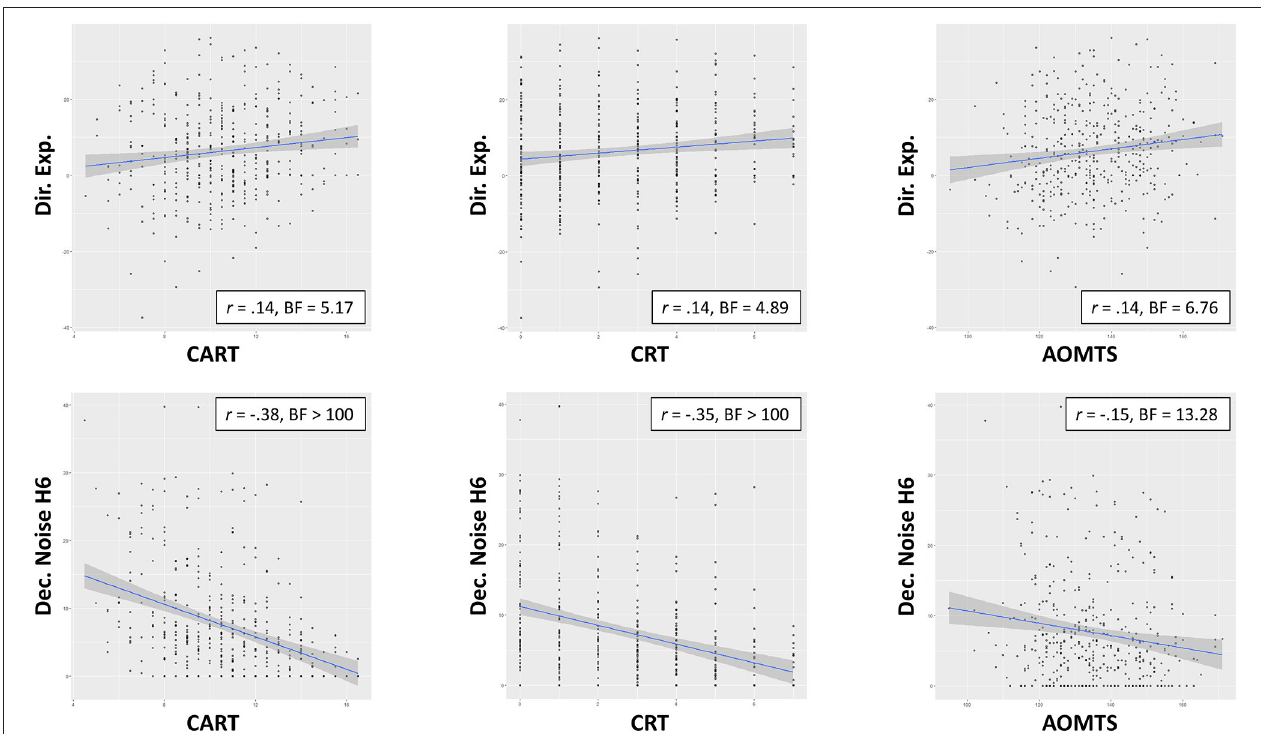
FIGURE 4 | Relationships between self-reported reflectiveness (CART. CRT-7, AOMTS), directed exploration, and decision noise. Greater reflectiveness was associated greater exploration and reduced decision